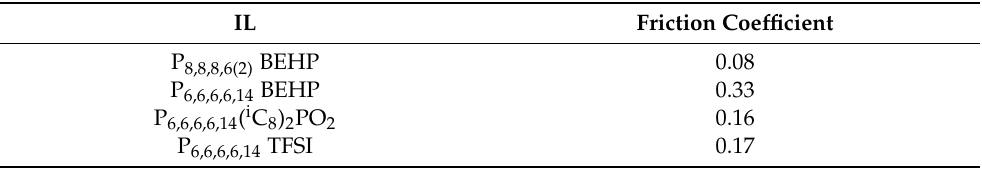
Table 6. Friction coefficients of some ILs used as